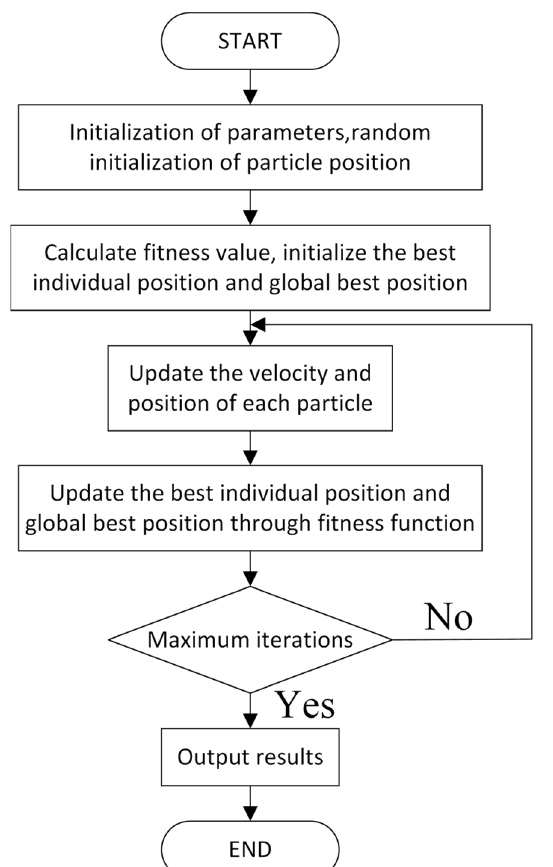
Figure 9. Flowchart of HPSO algorithm.